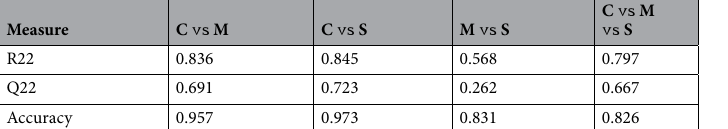
Measure C vs M C vs